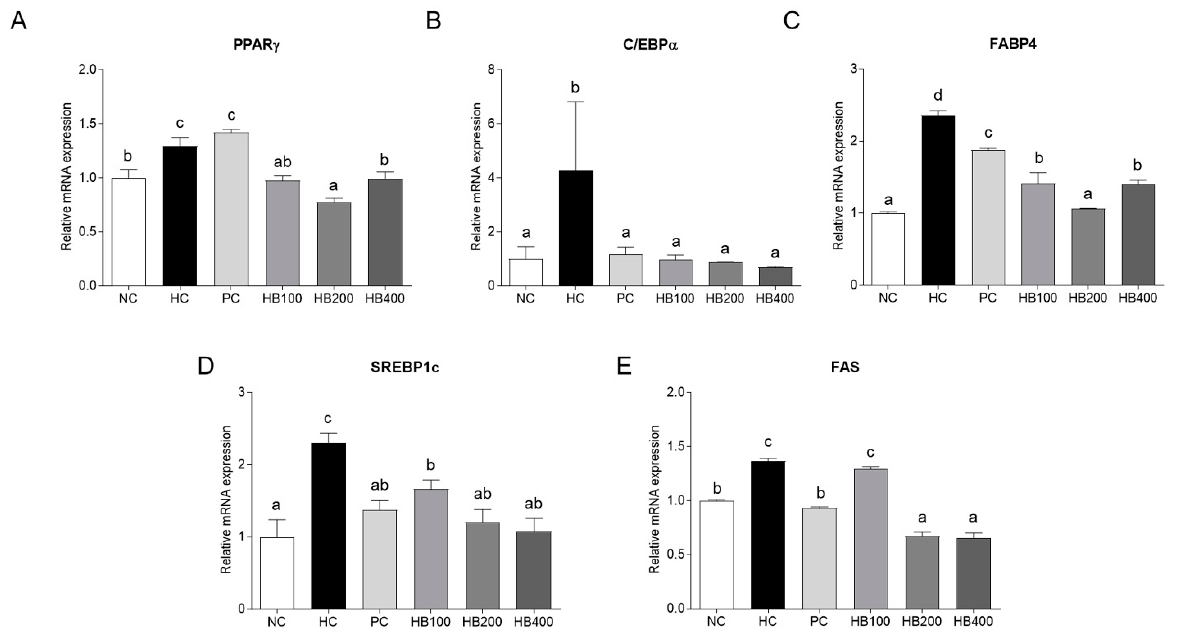
Figure 3. Effects of HB on the expression levels of genes related to the lipid metabolism in epididymal fat tissue of HFD-fed mice. All data are mean ± SD. Significant differences among six groups are expressed as different letters based on one-way ANOVA ( p < 0.05), followed by Duncan’s multiple range tests.